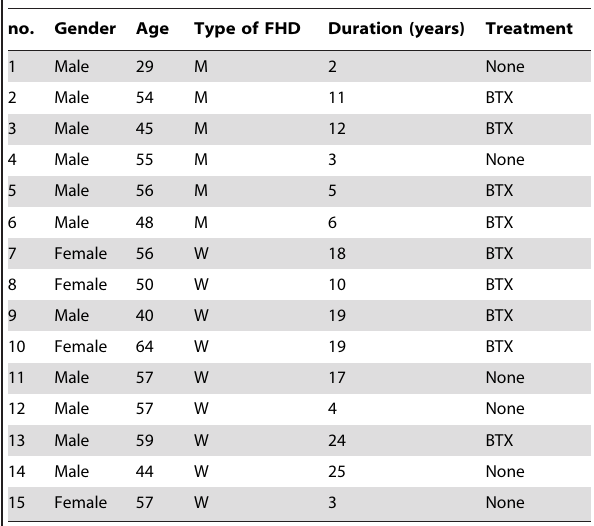
Table 1. Demographic and clinical details of FHD